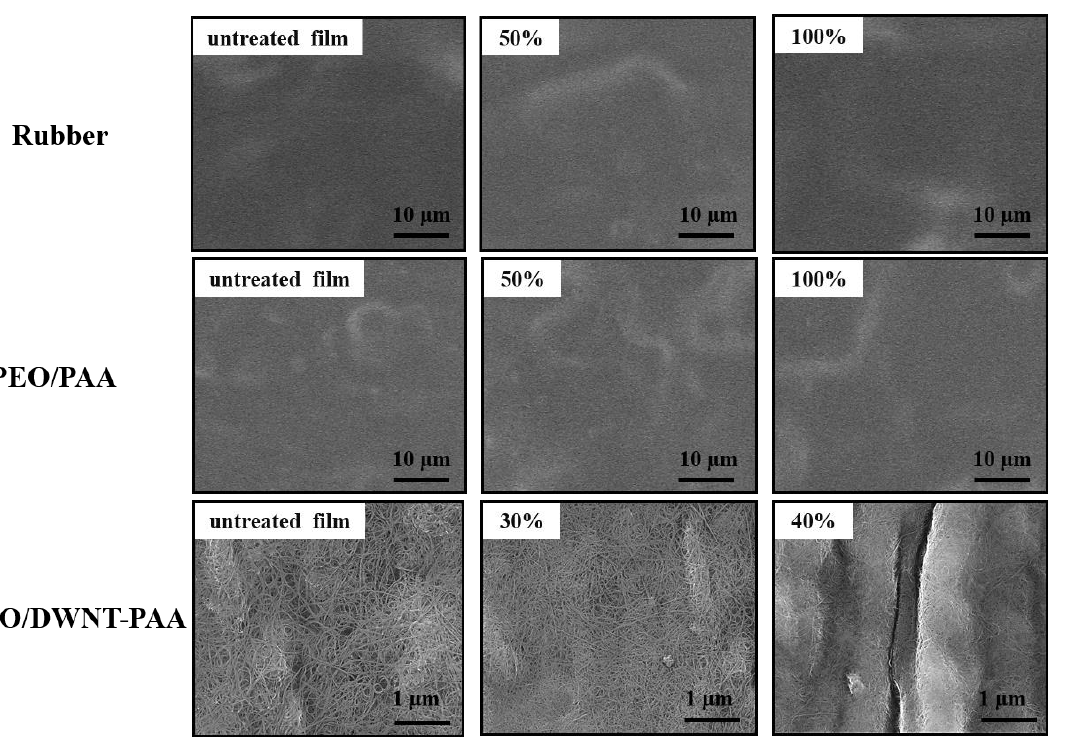
Figure 5. SEM surface images of uncoated PU rubber and 25 bilayer PEO / PAA and PEO / DWNT-PAA assemblies, on 0.7 mm thick polyurethane rubber, before and after being subjected to varying levels of